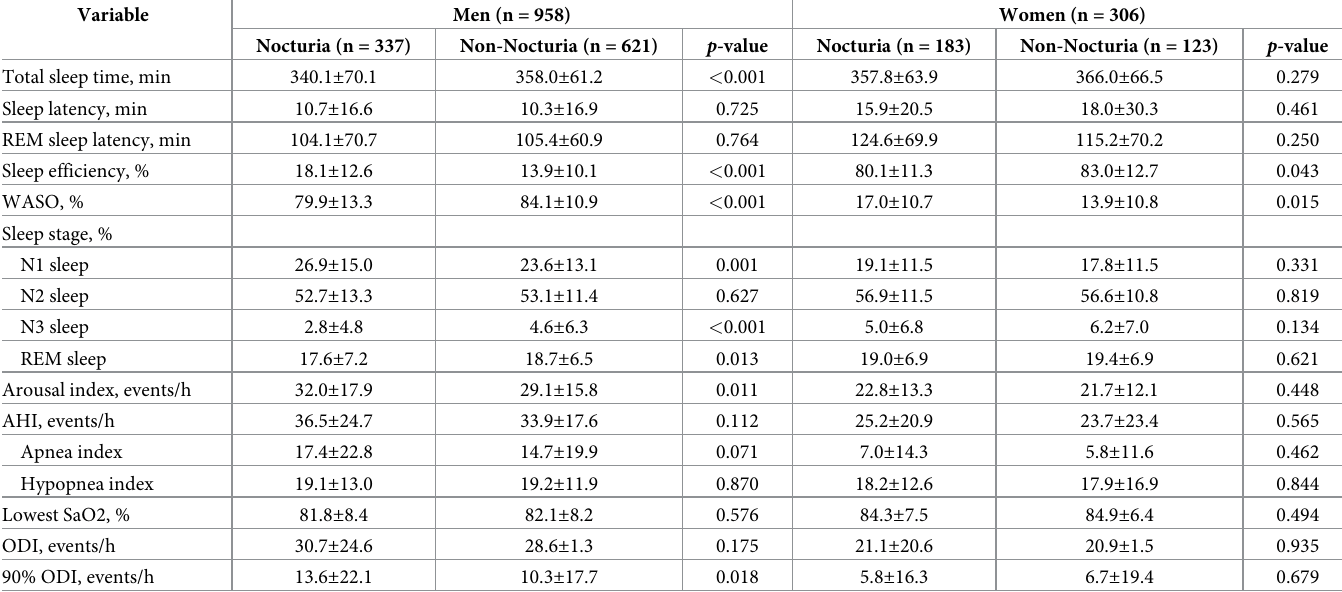
Table 2. Polysomnography parameters by group and sex (N =